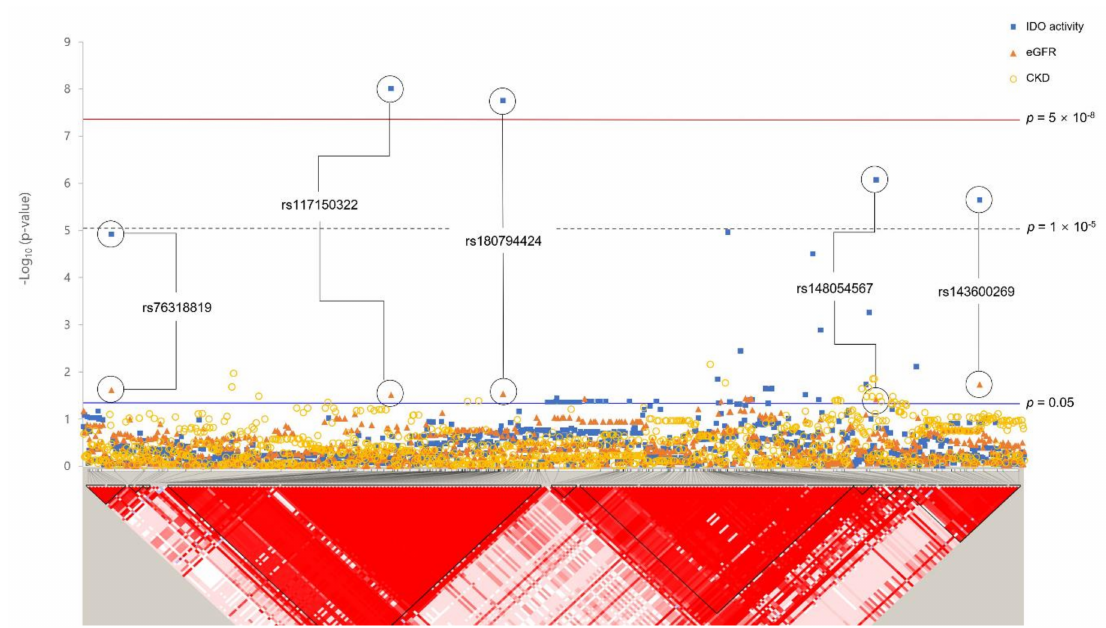
Figure 2. Plot of p -values of studied variants within TNFRSF19 ± 100 kb regions. Results of association analysis between variants and IDO activity, eGFR, and CKD are plotted. Standard significant p -value threshold ( p = 0.05) and GWAS p -value threshold ( p = 5 × 10 − 8 ) are indicated by blue and red lines, respectively. The bottom panel shows a Haploview of LD ( r 2 ) based on genotyping data from KARE data. It was generated using the Haploview program.